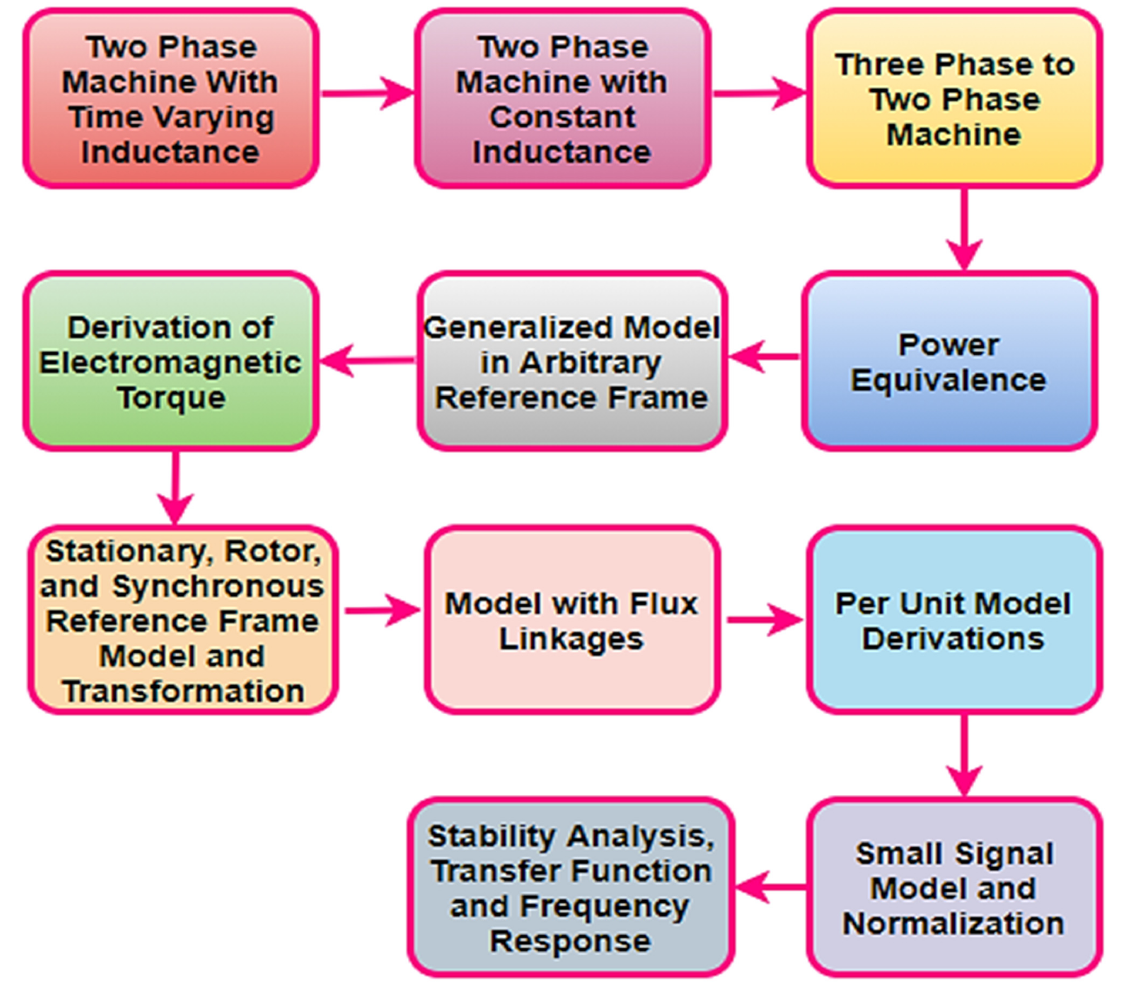
Figure 2. Three-phase induction motor dynamic modeling.